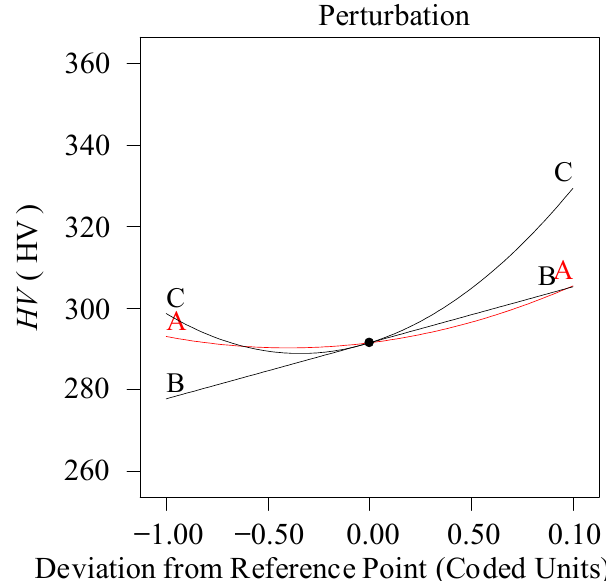
Figure 10 is the perturbation diagram of microhardness (the intersection point value: A: a p = 1.375 mm, B: ν c = 150 m / min, C: f = 0.1 mm / rev). The analysis demonstrates that the feed rate and cutting speed are the major influencing parameters.